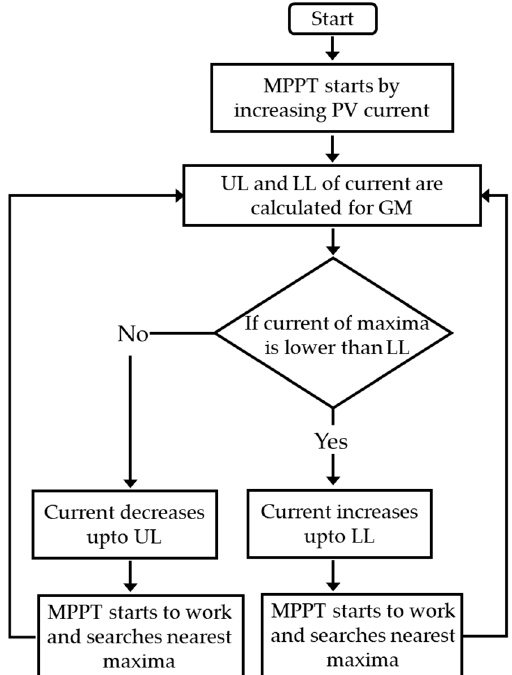
Figure 5. The maximum power point tracking (MPPT) algorithm to find the global maximum (GM) during the partial shading (UL is the upper limit, LL is the lower limit).